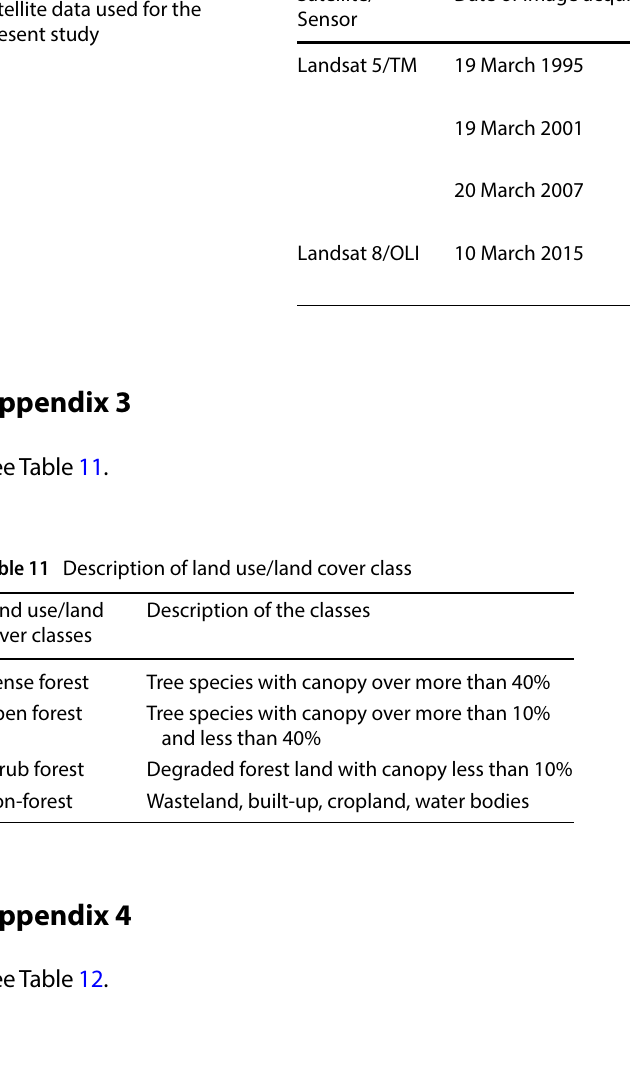
Table 12 Types of metrics level Metrics